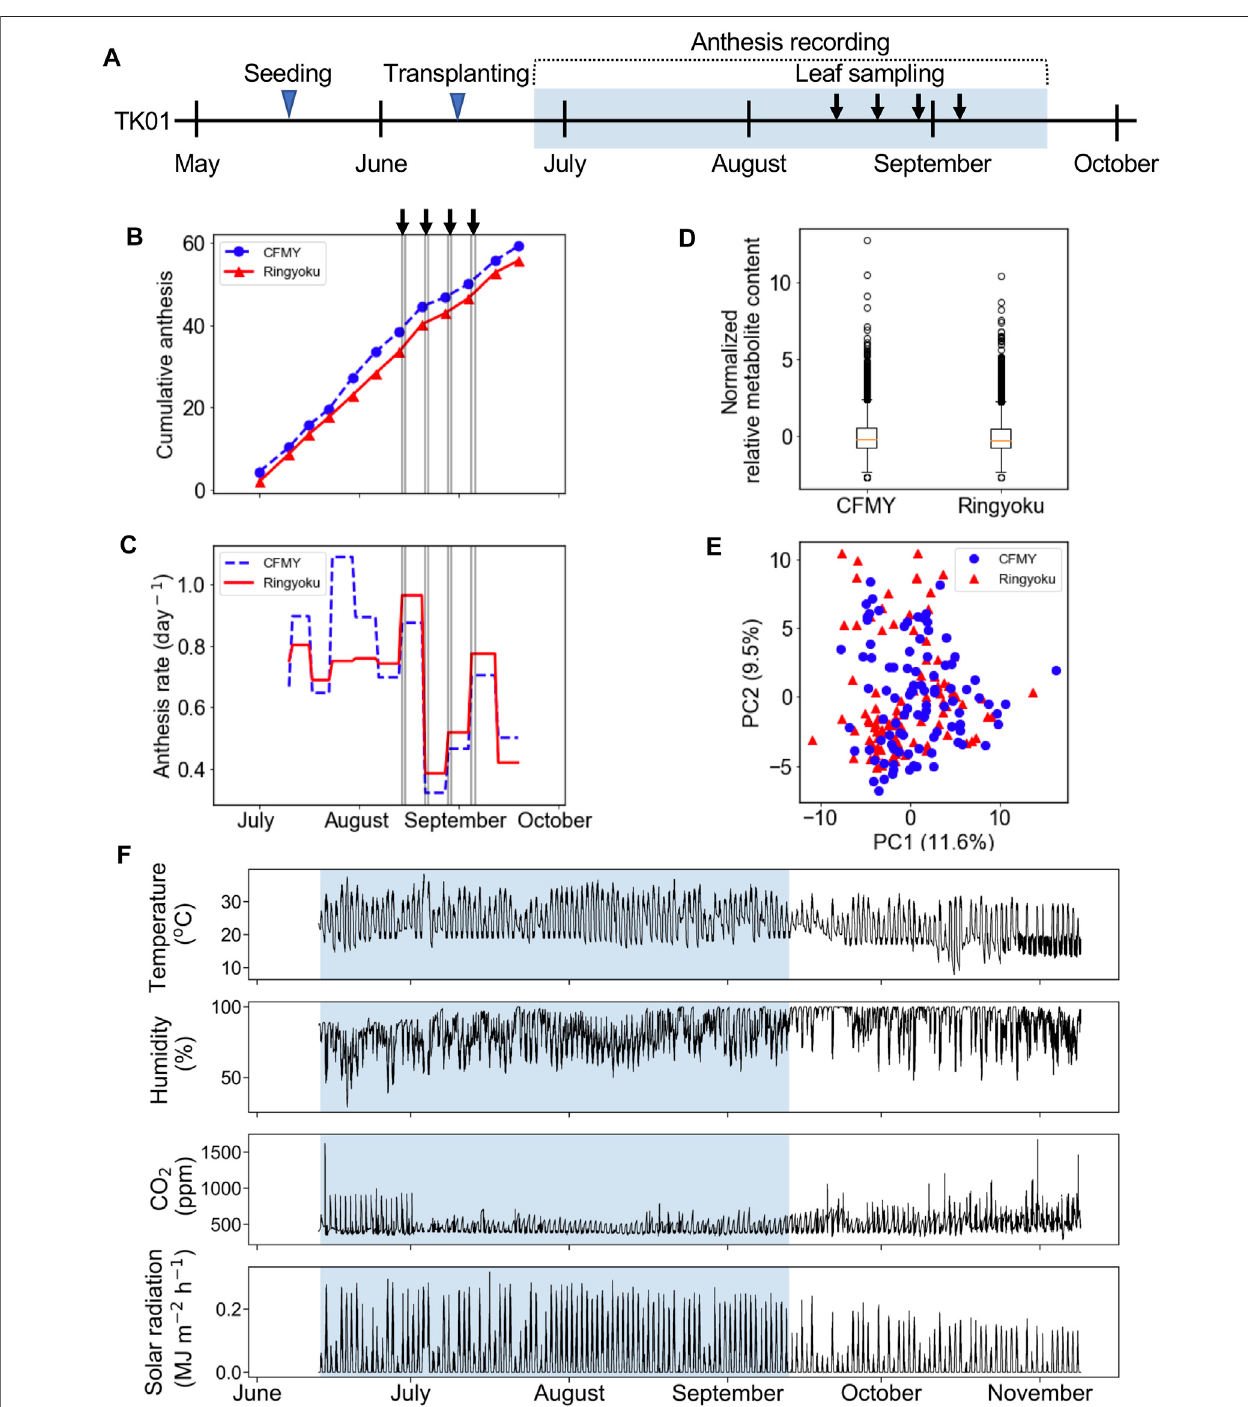
FIGURE 1 | Experimental design of TK01. (A) Experimental timeline for leaf sampling and observation of anthesis of cultivars CFMY and Ringyoku. The blue rectangle indicates the period of the measurement of environmental factors (e.g., temperature). (B) Cumulative anthesis. The arrows and gray vertical lines indicate the dates of leaf sampling for metabolome analysis. (C) Distributions of anthesis rates were statistically the same between cultivars (Mann-Whitney U test, p > 0.05, CFMY; n =21,Ringyoku; n =21). (D) Boxplotofthestandardizedrelativemetabolitecontentsof161metabolitesin192leafsamples(CFMY; n =96,Ringyoku; n =96). (E) PCAscoreplotofthe fi rsttwocomponents(PC1andPC2)ofleafsamples(CFMY; n =96,Ringyoku; n =96).Themetabolicpro fi lesofthe161metaboliteswereusedfor PCA. The numbers in parentheses in the axes are contribution ratios. (F) Environmental conditions measured in the experimental timeline. The environmental data in the blue background color used for LASSO analysis (E-model and C-model). The period in the blue background color is consistent with the period for leaf sampling.